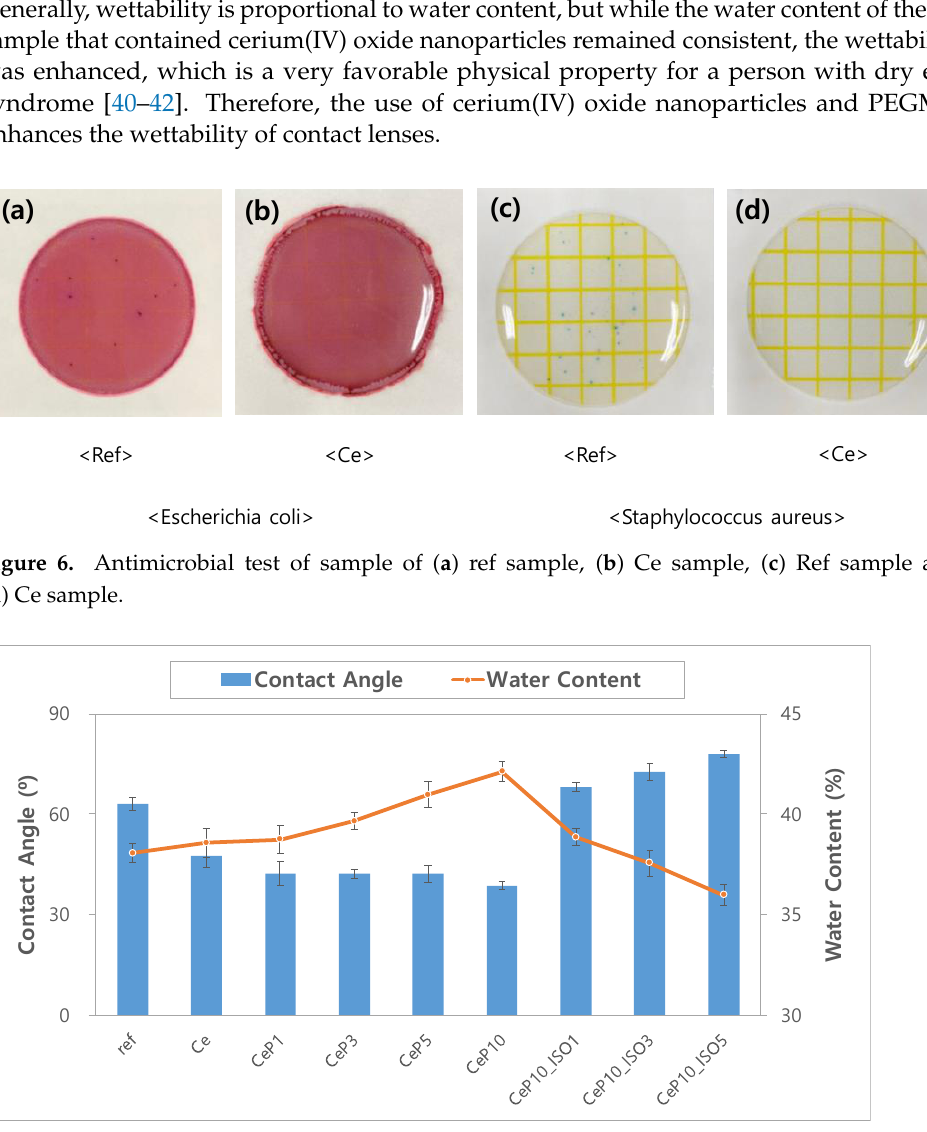
Figure 6. Antimicrobial test of sample of ( a ) ref sample, ( b ) Ce sample, ( c ) Ref sample and ( d ) Ce sample.